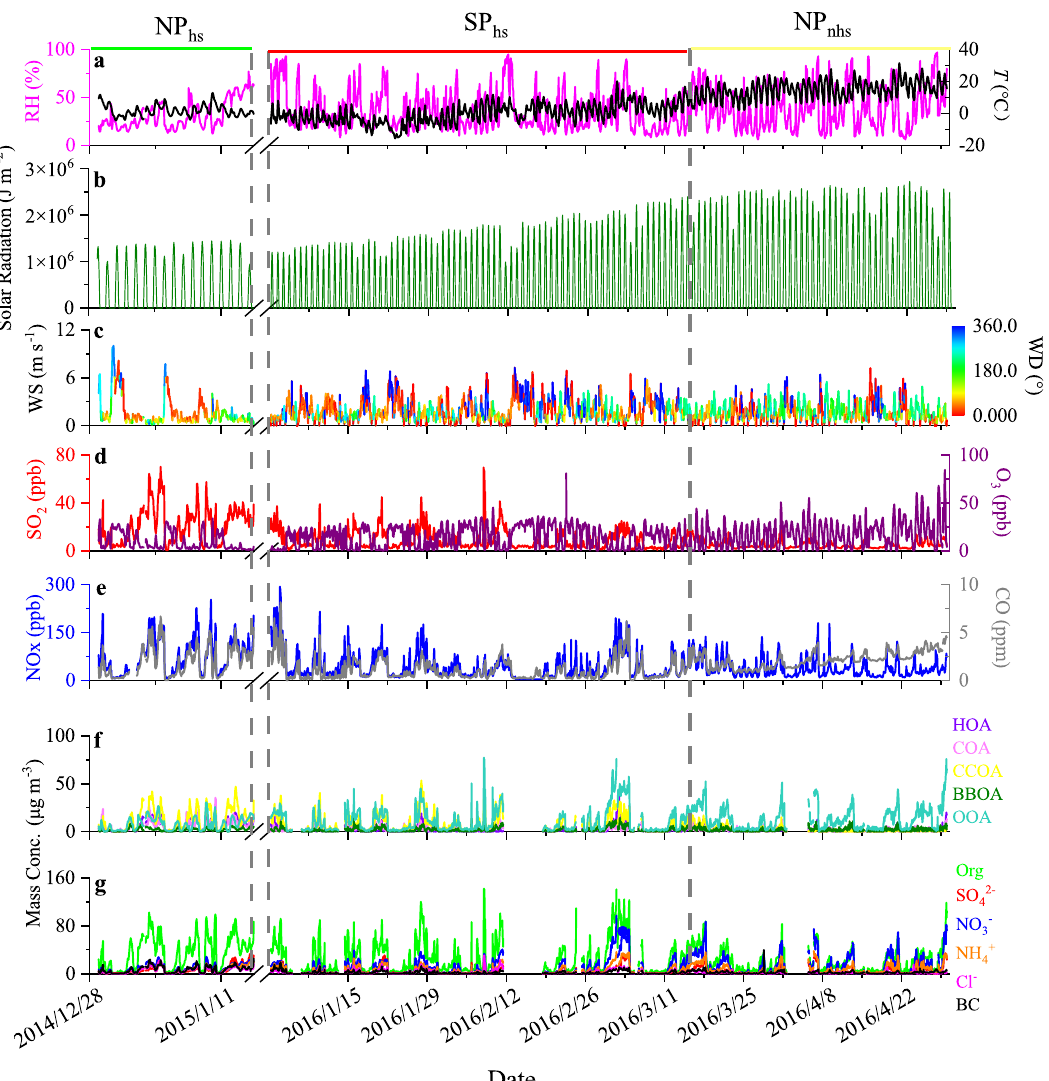
Fig. 1 Time series of PM 1 species, OA factors, gaseous precursors, and meteorological parameters for the NP hs , SP hs and NP nhs . Time series of a temperature ( T ) and relative humidity (RH), b surface net solar radiation, c wind speed (WS) and wind direction (WD), d SO 2 and O 3 , e NOx and CO, f OA factors (HOA, COA, CCOA, BBOA, and OOA), g PM 1 species (organic, sulfate, nitrate, ammonium, chloride and black carbon) for the NP hs , SP hs and NP nhs . NP hs represent the normal production period in the heating season from December 29th, 2014,